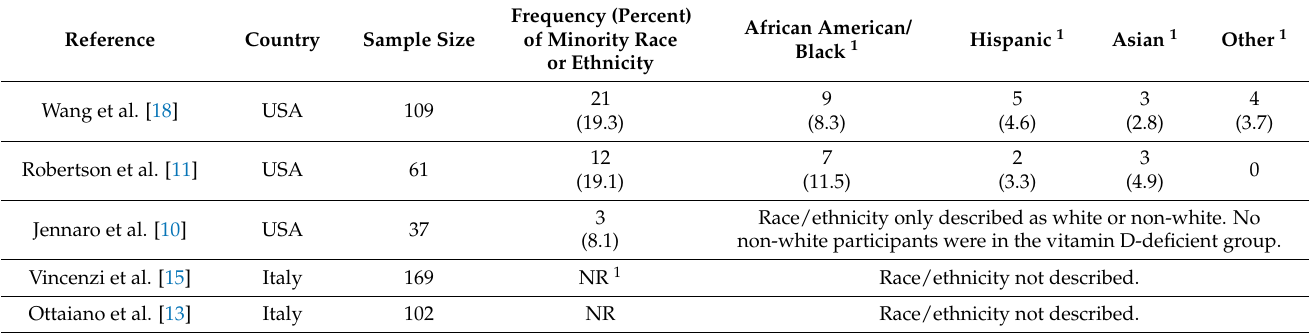
Table 2. Racial and ethnic minority